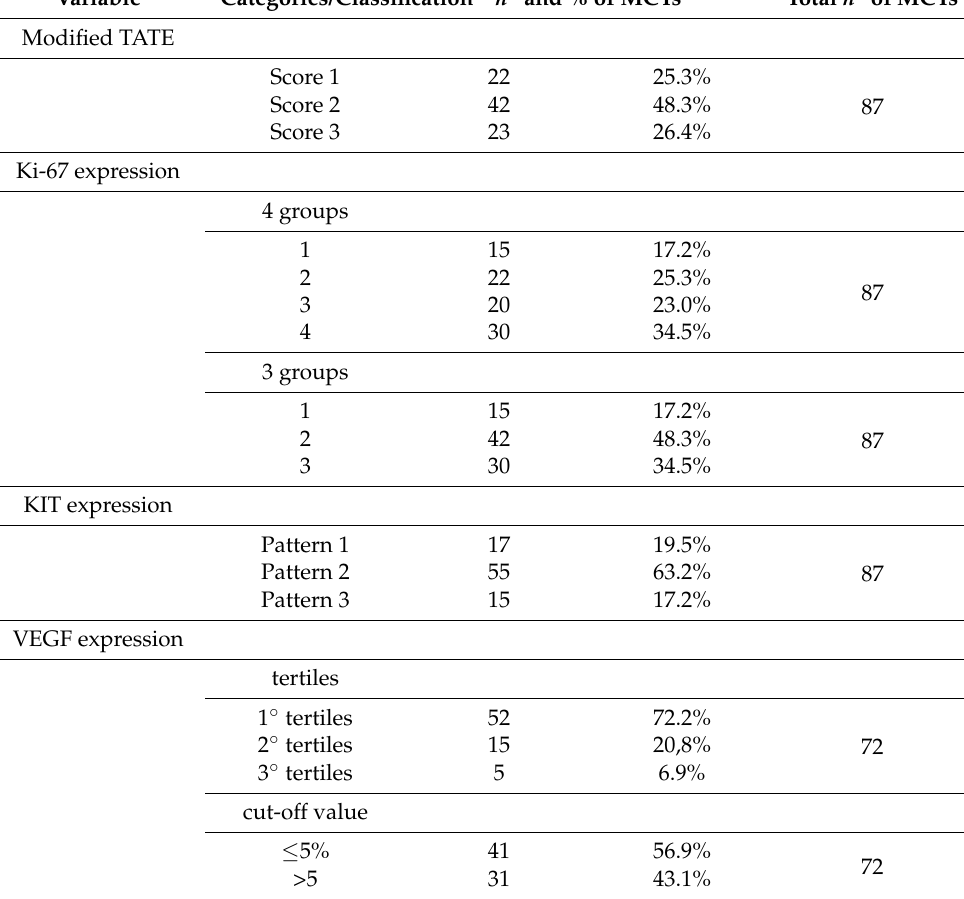
Table 2. Summary of the results for the different variables analyzed and their categories/classification. Modified TATE is expressed in three scores; Ki-67 values are both divided in 4 and in 3 groups; KIT in three patterns of expression; VEGF expression is reported in tertiles and with a cut-off value of 5%.